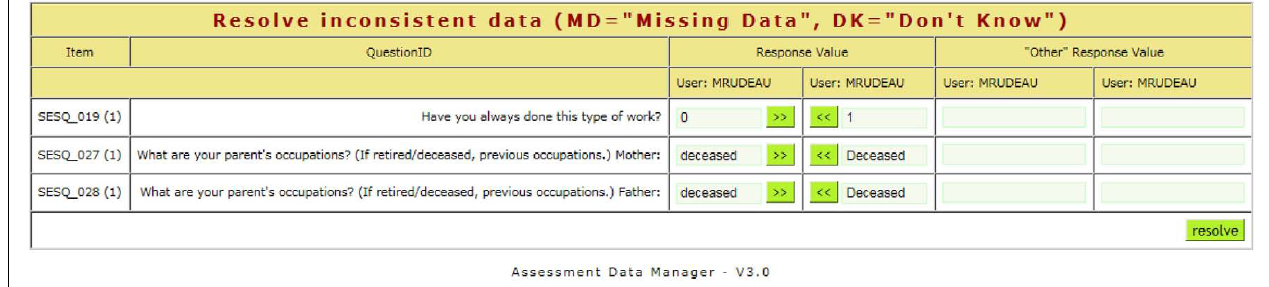
FIGURE 5 |ASMT supports user-defined calculated fields, including conditional if statements and a built-in reverse scoring function, among others. In this example, the formula divides the question